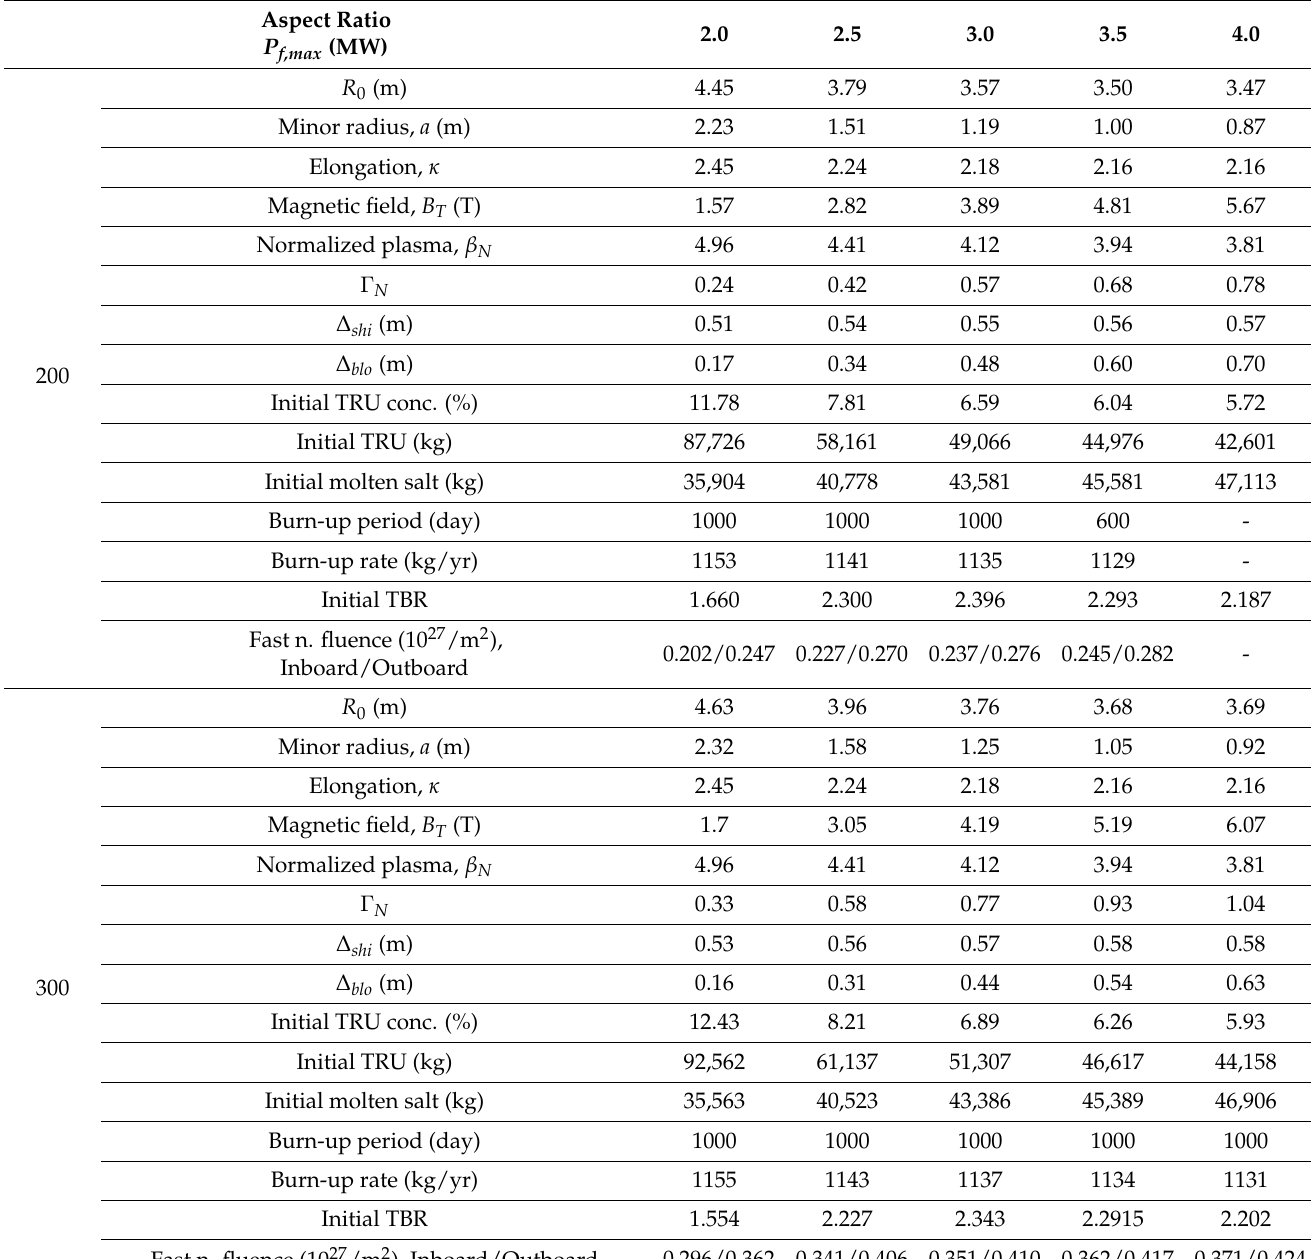
Table 3. System parameters and transmutation properties for various A and P f,max with